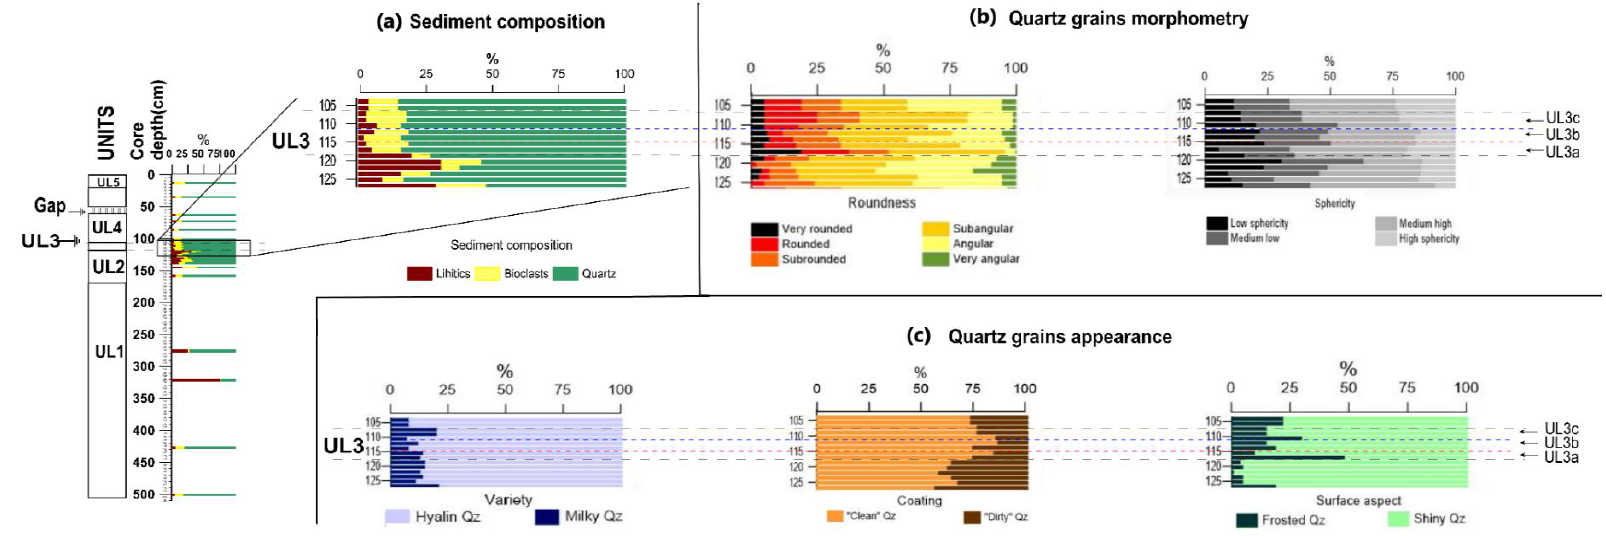
Figure 4. Results of the morphoscopic study: ( a ) sediment composition; ( b ) morphometric parameters of quartz grains (roundness and sphericity); ( c ) quartz grain appearance (variety, coating, and surface aspect). Roundness is classified following the Power scale (1957): 0—well rounded, 1—rounded, 2—subrounded, 3—subangular, 4—angular, 5—very angular. Sphericity is classified following Krumbein and Sloss (1951): 0—low sphericity, 1—medium—low sphericity, 2—medium-high sphericity; 3—spherical grains.